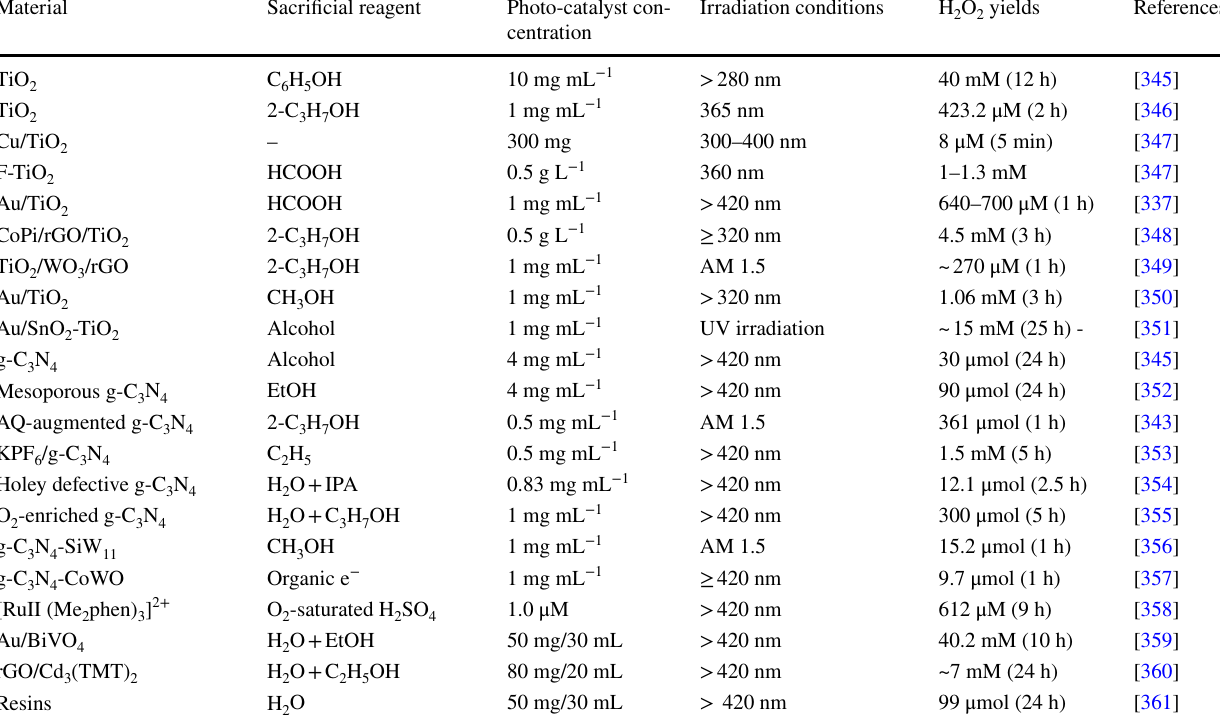
Table 3 Summary of photo‑catalytic H 2 O 2 production